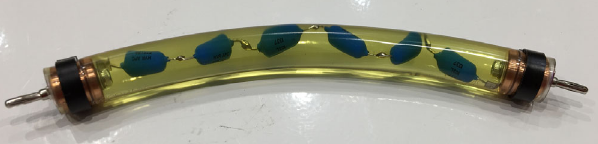
FIG. 3. Photograph of a solid, high-impedance charging re- sistor. Each resistor (blue pills) is a 10 k Ω , 7.5 kV, axial package, P/N: RT818A103L from HVR. Resistor housing is Tygon tube. The tube is filled with highly-processed transformer oil, degassed over night and then sealed with copper end-plugs and plastic clamps. End connections vary; this assembly uses banana plugs where others use fork terminals, ring lugs,